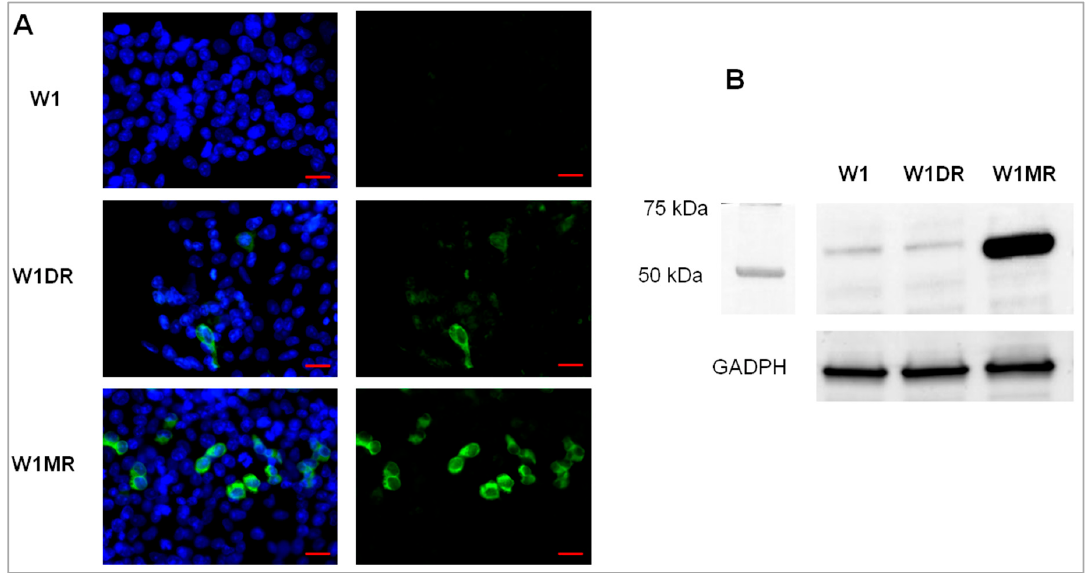
Figure 5. ( A ) Immunofluorescence visualization of ALDH1A1 protein expression in the W1, W1DR, and W1MR cell lines. W1—no ALDH1A1-positive cells; W1DR—a few cells with high expression of ALDH1A1 (less than one percent); W1MR—clear cell subpopulation with high expression of ALDH1A1. ALDH1A1 was detected using the anti-ALDH1A1 antibody and MFP488-conjugated secondary antibody (green). To visualize the cell nuclei, the cells were mounted with a DAPI-containing mounting medium (blue). Objective ×40. Scale bar = 20 µm. ( B ) ALDH1A1 protein expression analysis in the cell lines. The cellular proteins were separated using 7% PAGE and transferred to a PVDF membrane, which was then immunoblotted with either primary Ab or HRP-conjugated secondary Ab. A primary anti-GADPH Ab was used as a loading control for the cell lysates.